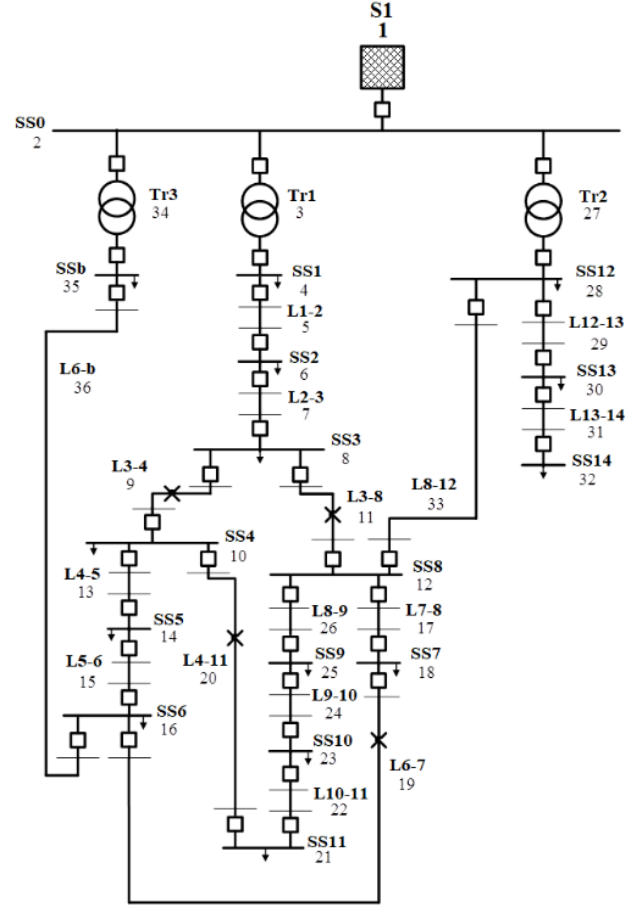
Figure 6. Structure 4 of the distribution network .